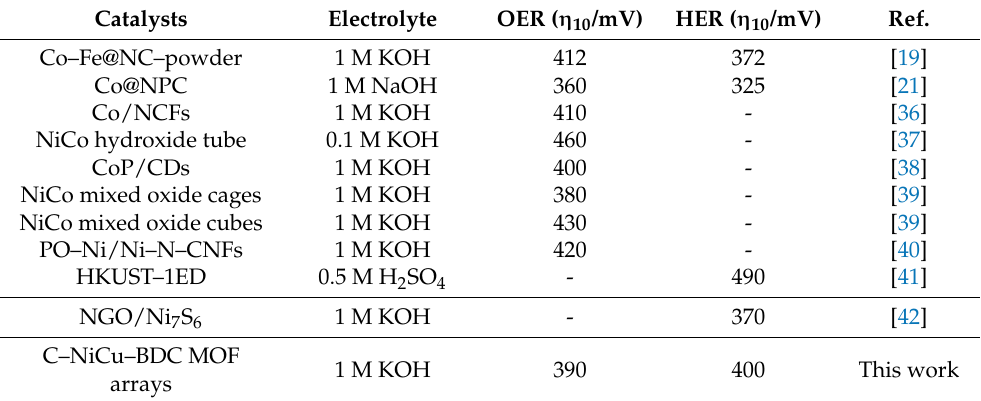
Figure 4. Electrochemical measurements in the three-electrode system. ( a ) LSV curves of C–NiCu– MOF arrays, powder, and bare CC. ( b , c ) Fitted EIS data of the C–NiCu–MOF arrays, powder, and bare CC for HER and OER, respectively. Table 1. Comparison of the HER and OER performances with previously reported comparable